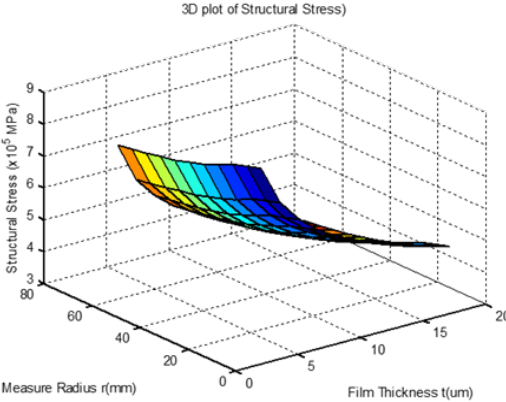
Figure 5. Numerical simulation for the dependences of the structural stress of SiO 2 film on both the measured radius and the thickness.